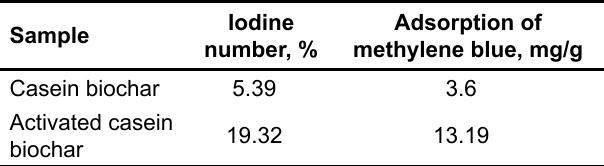
Table 3. Adsorption of casein biochar and activated